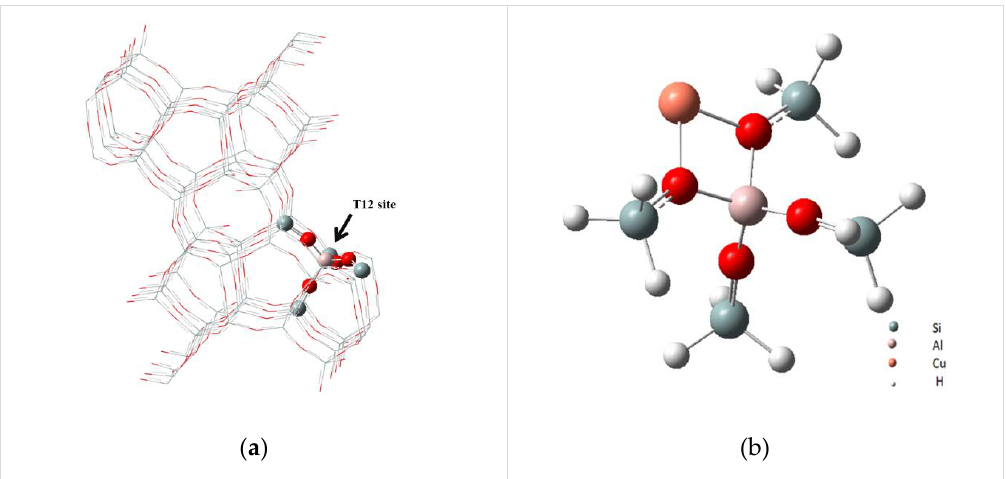
Figure 3. Structure diagram of the computational model. ( a ) Location of the Al atom within the crystal structure of ZSM-5; ( b ) optimized 5T model of Cu-ZSM-5. Gaussian-09 software package (Gaussian 09, Revision A.02, Gaussian, Inc., Wallingford, CT, USA,